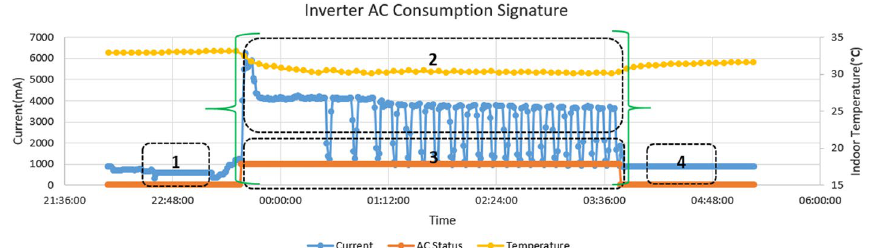
Fig. 8 Sample graph of identifying an inverter AC usage